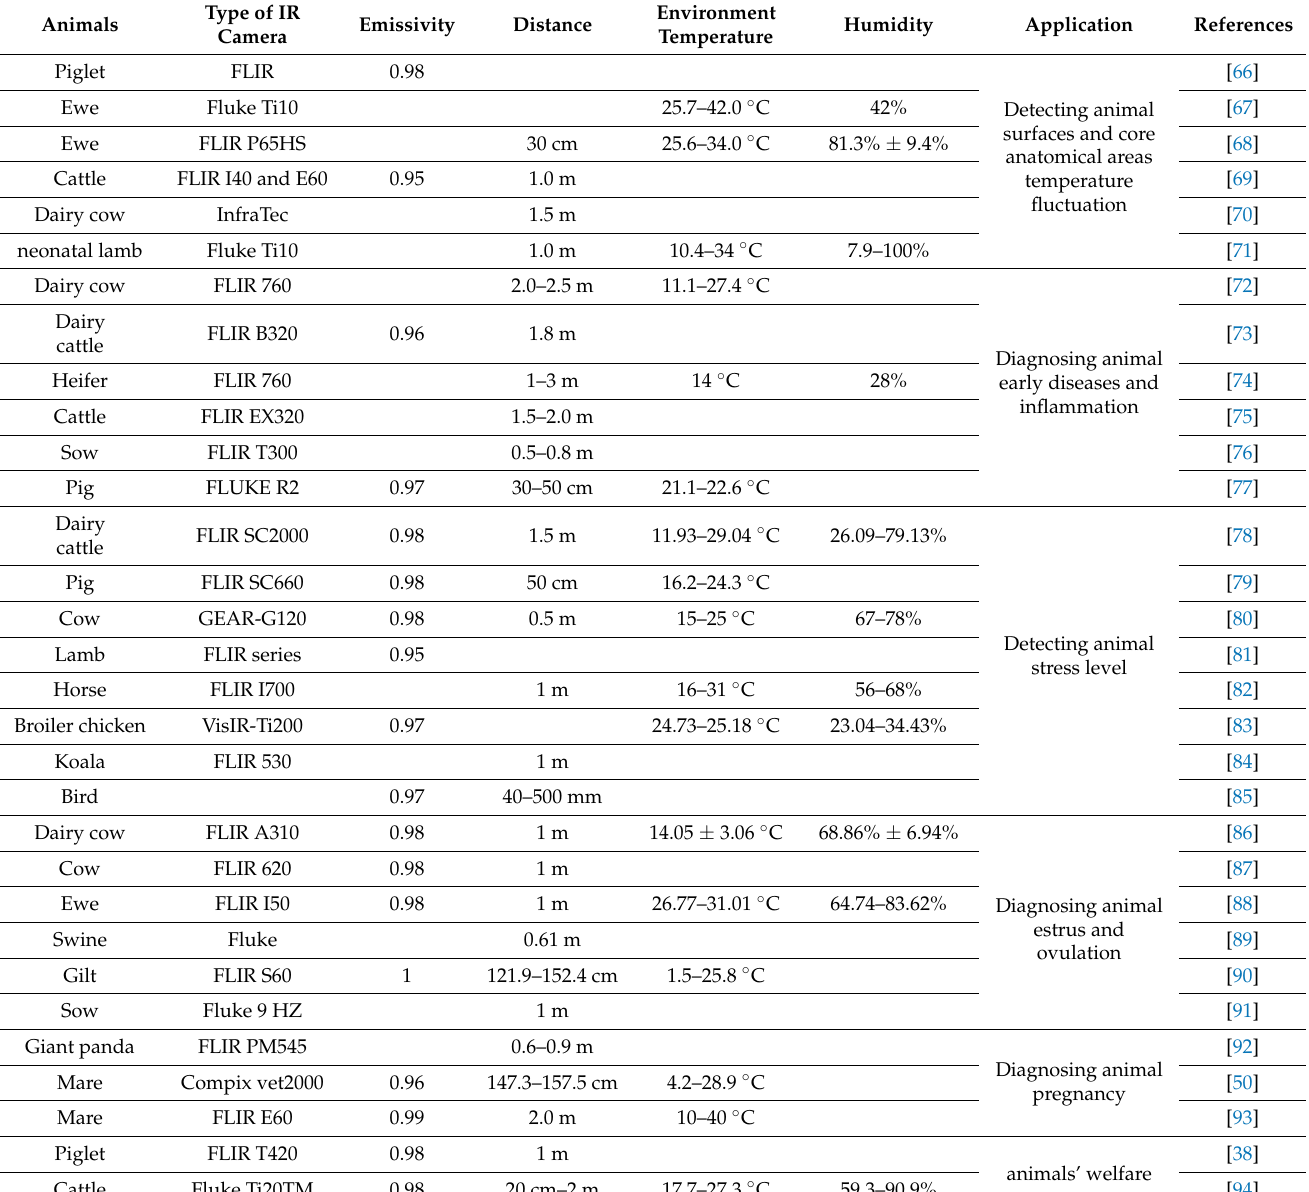
Abbreviations: Blank part of the table: no relevant parameter